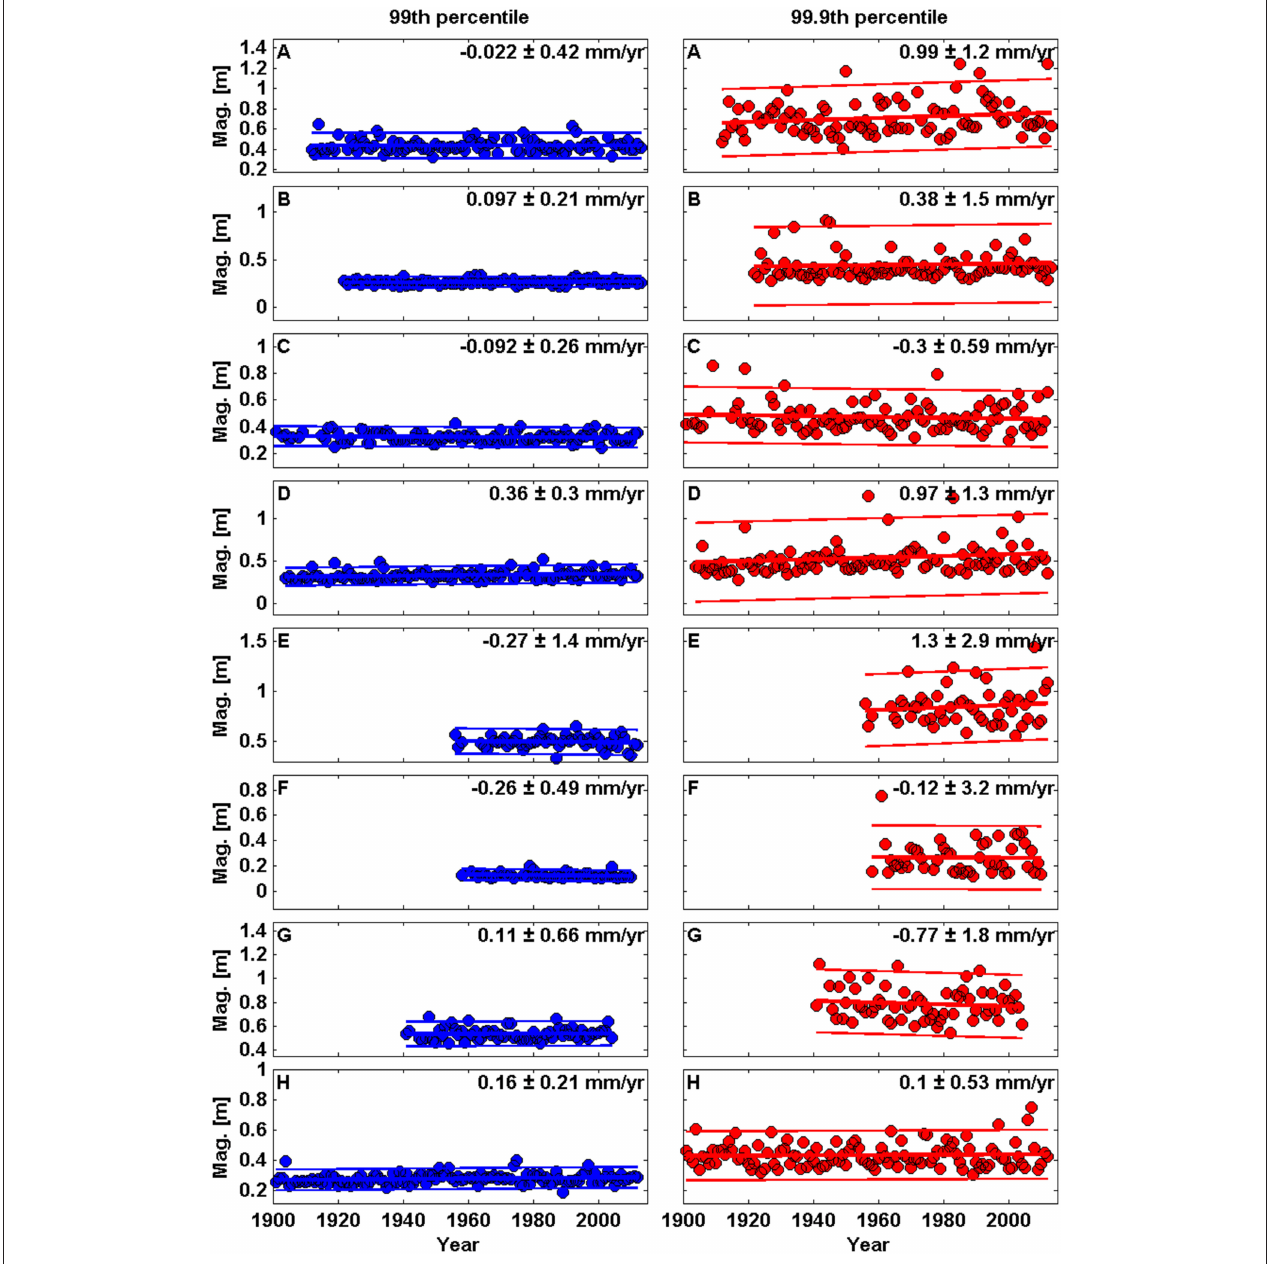
FIGURE 6 | Time series plots of annual values of the 99th (blue) and 99.9th (red) percentile for skew surge at 8 selected sites. (A) Atlantic City, USA; (B) Charleston, USA; (C) Fremantle, Australia; (D) Galveston, USA; (E) Immingham, UK; (F) Naze, Japan; (G) Port Adelaide, Australia; (H) Seattle, USA. that site and each of the other 219 sites. The results are shown in Figure 8 . There are distinct regions where strong positive correlations occur among neighboring sites. These include the Europe. Interestingly, sites on the west coast of the US are weakly anti-correlated (at the 66% level) with several sites in northern